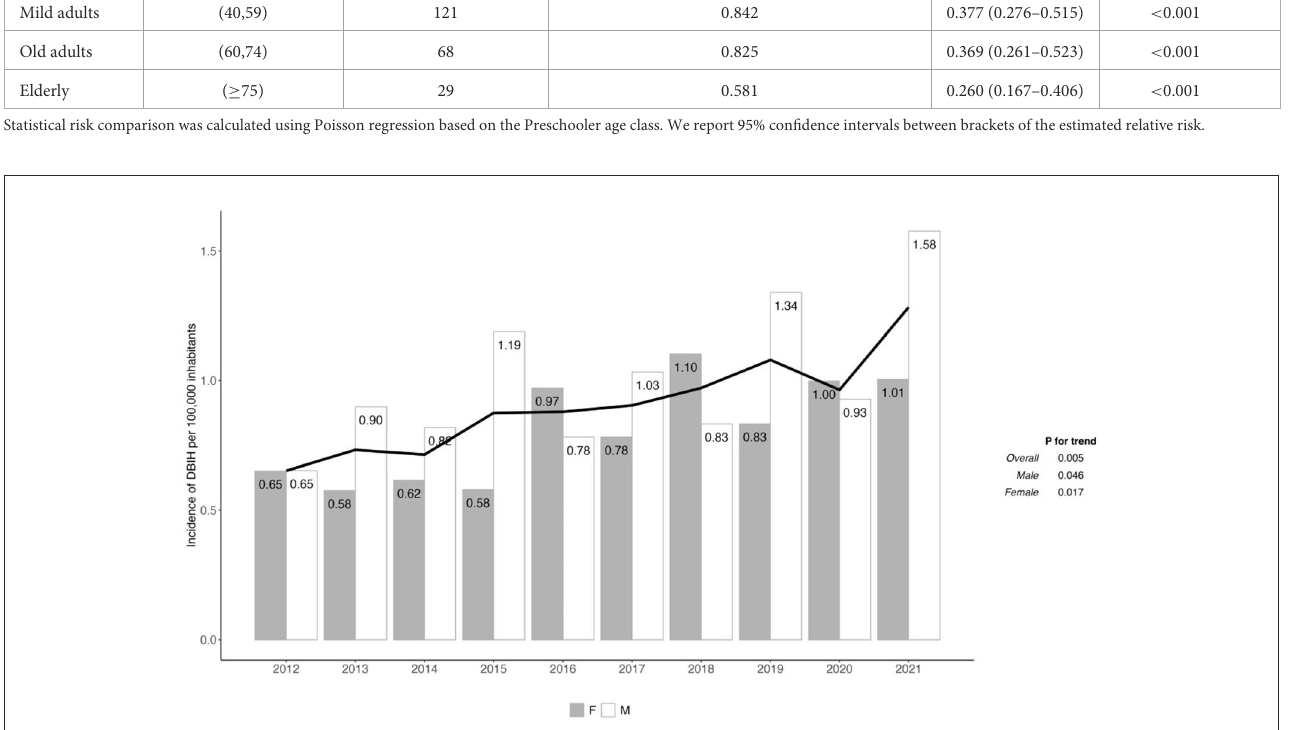
miscommunication in body language between dog and child (23).